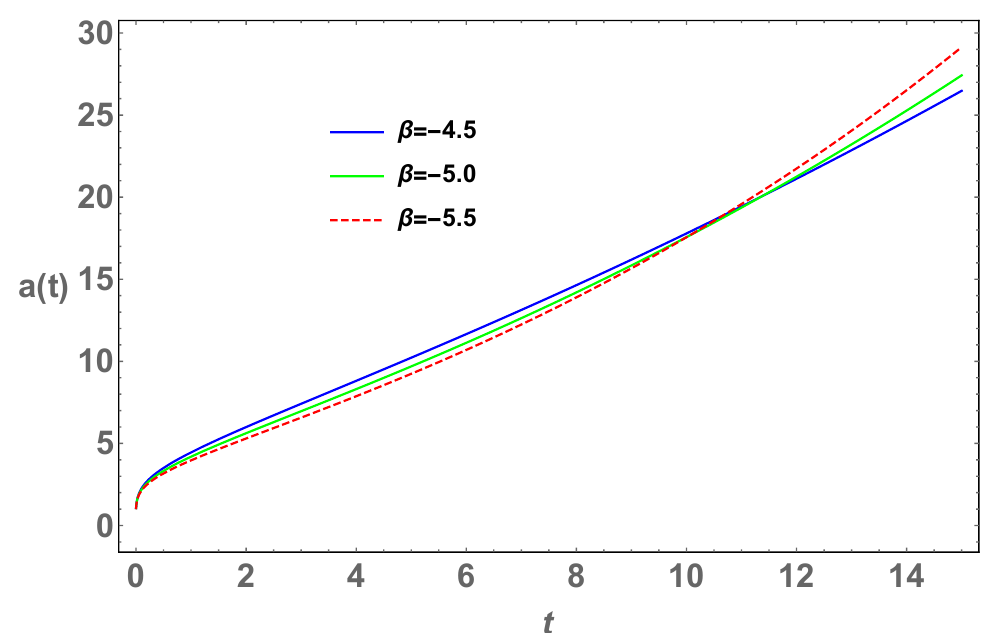
Figure 1. Evolution of scale factor a ( t ) with respect to cosmic time t for different values of β with α = − 1.5, b = 0.2.